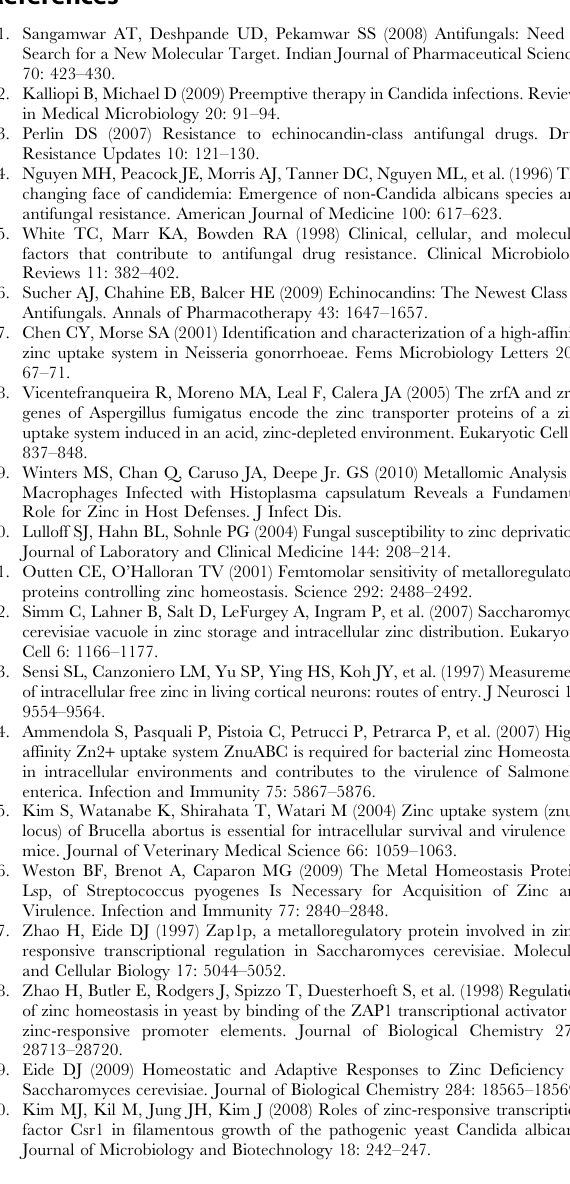
were analyzed for conserved functional motifs. Motifs of human CDF and Zip group I transporter are shown in red, hZip group II in blue and fungal transporters in green. TMpred and ClustalW2 were used for motif analysis. (TIF) Table S1 Summary of Hit Compounds. (PDF) Table S2 Protein sequence comparison between human and fungal A) Zip and B) CDF transporters.